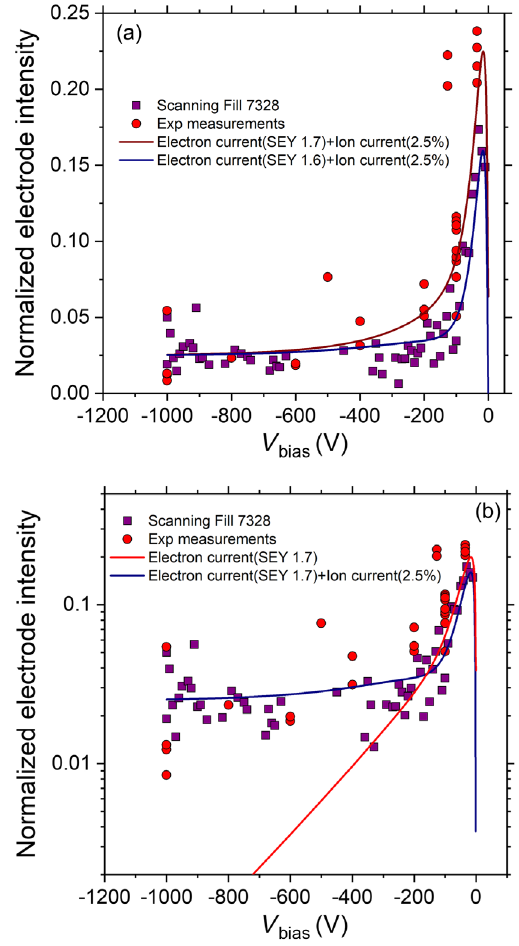
FIG. 16. Normalized electrode intensity vs V data recorded during several fills (red circles) or during fill 7328 (purple squares) are compared to calculated intensities by adding 2.5% of positive ions and taking a SEY of 1.6 (blue line) or without ions and taking a SEY of 1.7 (red line): linear (a) or logarithmic (b) y